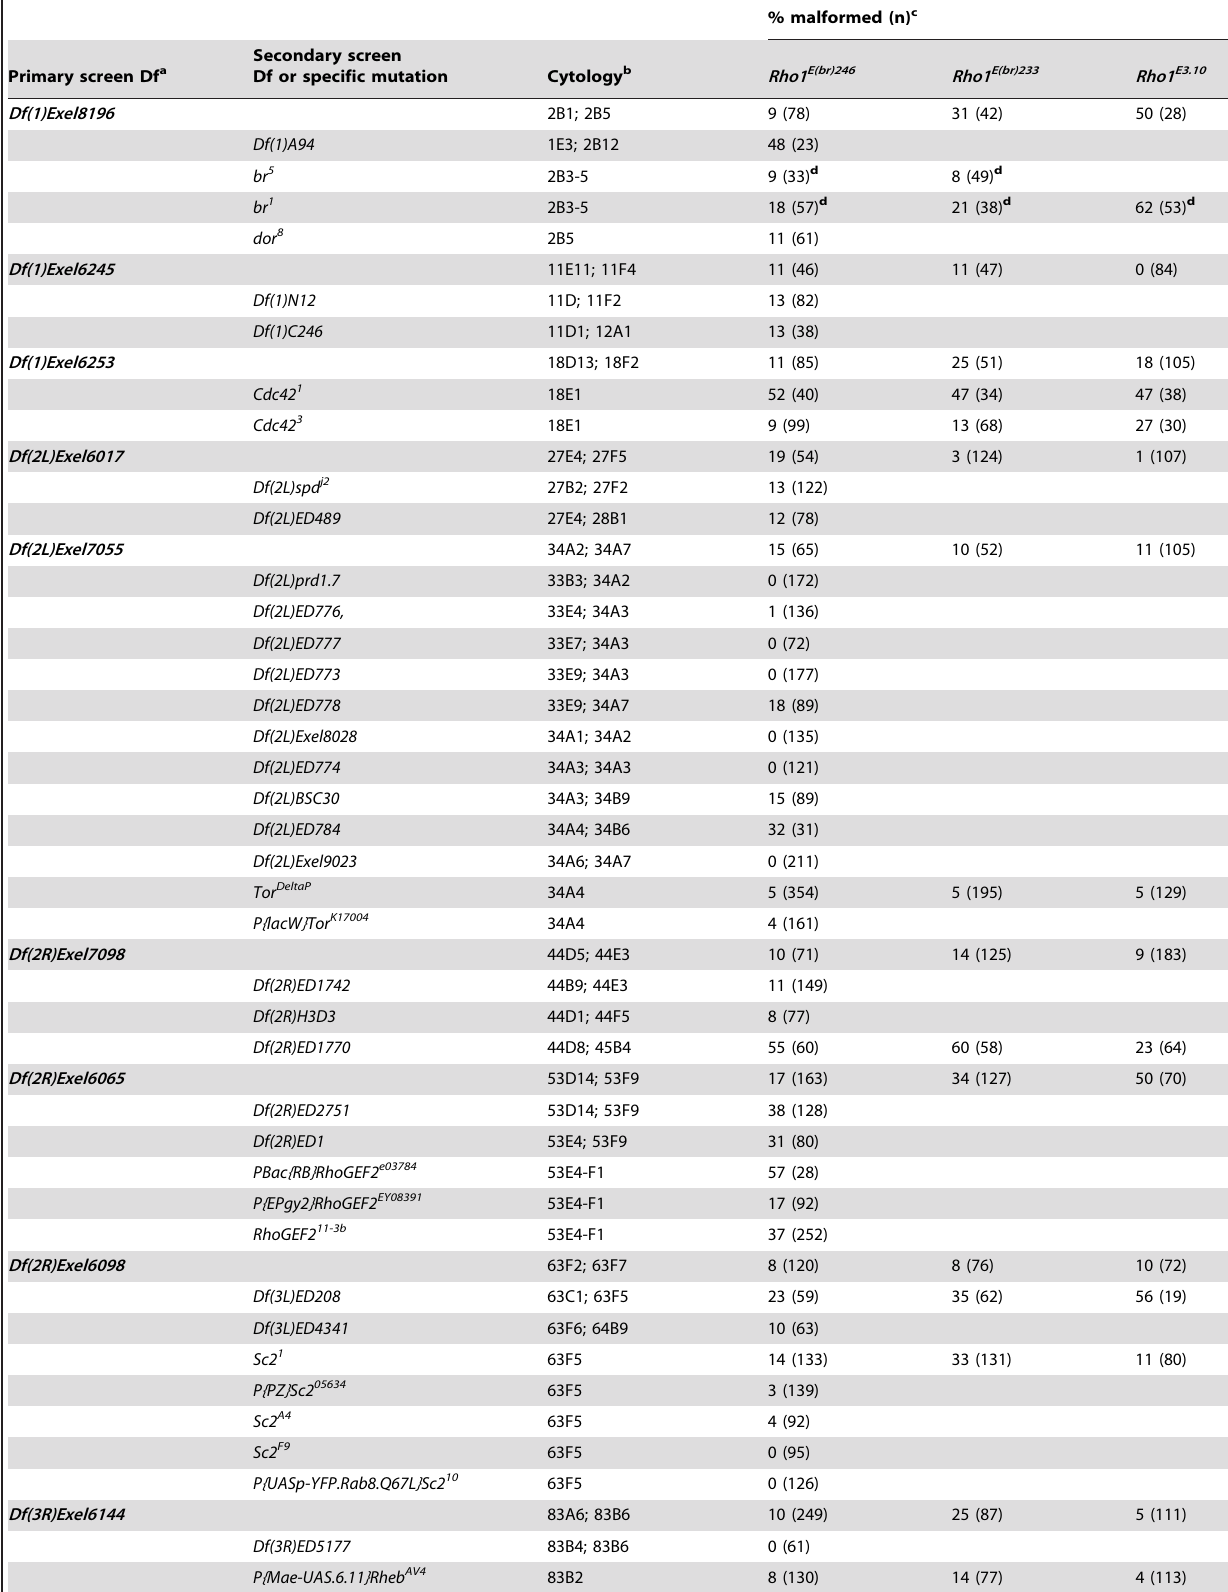
Table 2. Summary of Rho1 -interacting deficiencies and specific